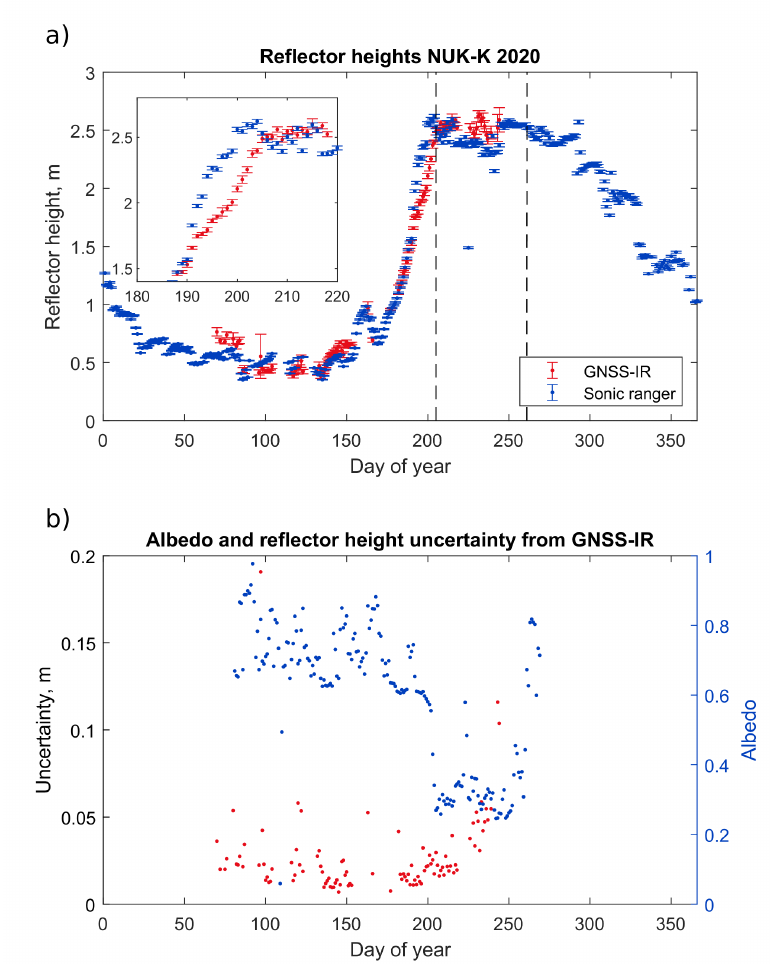
Figure 4. ( a ) Daily average reflector heights measured by GNSS-IR and the sonic ranger on the boom. The GNSS-IR reflector height has been corrected for a bias as compared to the sonic ranger. The bars are the uncertainty estimated as the daily standard deviation of mean. The dashed lines indicate when the snow cover is effectively lost in the summer and when the first snow returns in the autumn as indicated by the albedo. ( b ) Albedo estimated from in- and outgoing shortwave radiation together with the uncertainty on the estimated daily reflector heights from